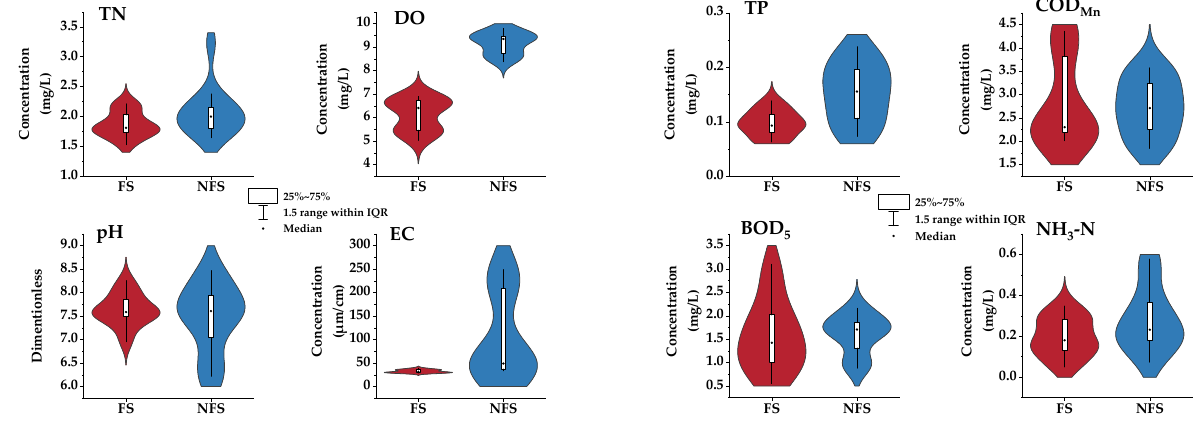
Figure 2. Distribution of water quality monitoring results.